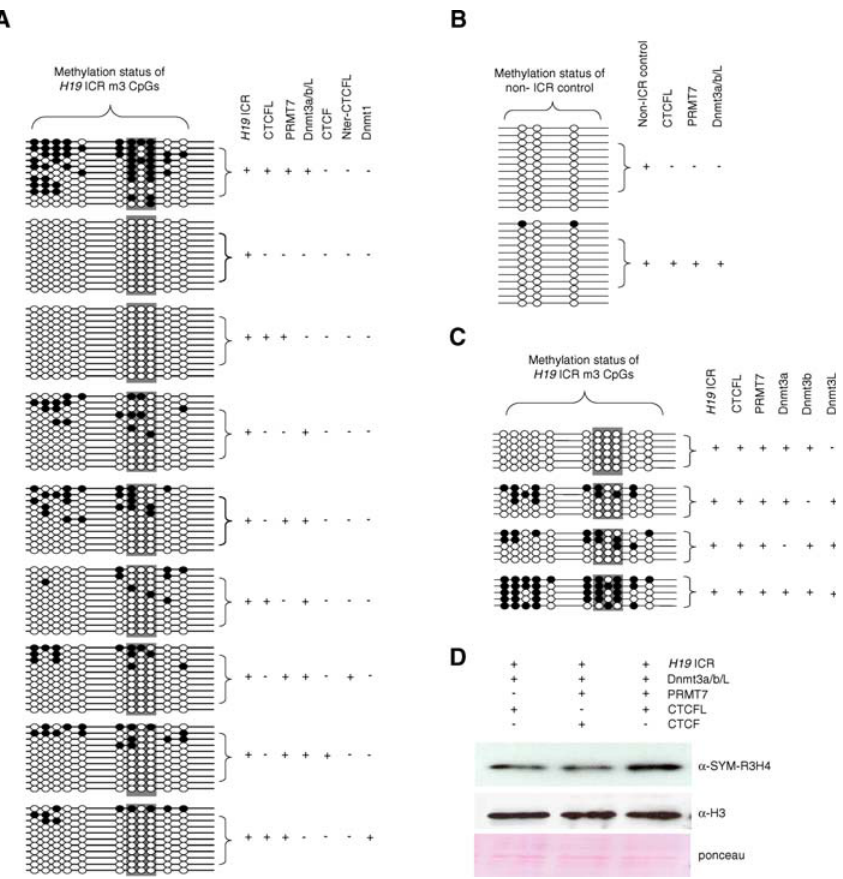
Figure 6. Analysis of De Novo H19 ICR Methylation by Nuclear Injection of Expression Plasmids into Xenopus Oocytes The experiment tests the ability of combinatorial expression of proteins encoded by the expression plasmids to methylate co-injected H19 ICR. A H19 ICR plasmid was co-injected with variety of cDNA expression plasmids; GFP fluorescence was used to select oocytes that had been properly injected. Efficiency of bisulfite modification was determined by evaluating transformation to T of non-CpG Cs. The maximum non-transformed Cs observed was one out of 51. (A) The specific expression plasmids co-injected with H19 ICR are indicated on the right side of the figure. Left panels indicate the methylation status of the 11 CpGs within the m3 region of the H19 ICR. Grey-shaded parts indicate the position of the CTCF consensus sequence within m3. Open circle ( * ) indictates non-methylated CpG; filled circle ( (cid:2) ) indicates methylated CpG. Optimal methylation is dependent on the expression of CTCFL, PRMT7, and all Dnmt3s. Oocytes were analyzed 48 h after injection. (B) Methylation analysis of co-injected control DNA plasmid . Organization of presented data is as for (A). The control fragment contains a unique sequence fragment present on Chromosome 8 and was also used as a control in ChIP analysis (Figure 2B and 2C). No significant methylation was observed with expression of CTCFL, PRMT7, and the Dnmt3a, -b, and -L, confirming sequence specificity of the ICR methylation analyzed in (A). (C) Functional analysis of the Dnmt3 isoforms. Organization of presented data is as for (A). Omission of Dnmt3L reduces methylation to 0%. Removal of either Dnmt3a or Dnmt3b significantly reduced observed methylation. Maximal ICR methylation is observed when all three Dnmt3s are co-injected with CTCFL and PRMT7. Oocytes were analyzed 72 h after injection. (D) Detection of SYM-R3H4 in sulfuric acid–extracted proteins from microinjected Xenopus oocytes. Expression plasmids injected are indicated on the figure. An increase in SYM-R3H4 is observed in the presence of both CTCFL and PRMT7. The middle panel shows reaction with an a -H3 antibody as a control for histone loading, whereas the lower panel shows ponceau red staining. DOI: 10.1371/journal.pbio.0040355.g006